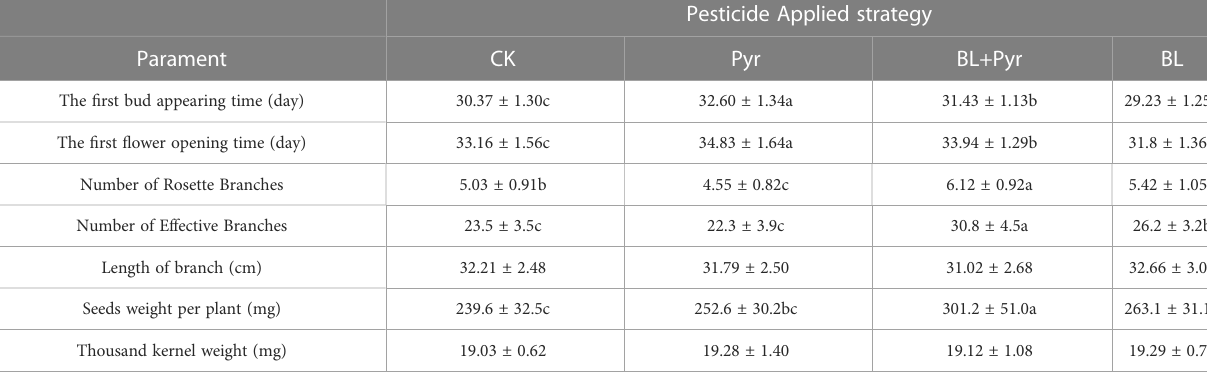
TABLE 3 The fl oral development, in fl orescence architecture, and seed yield parameters. Pesticide Applied strategy Parament CK Pyr BL+Pyr BL The fi rst bud appearing time (day)